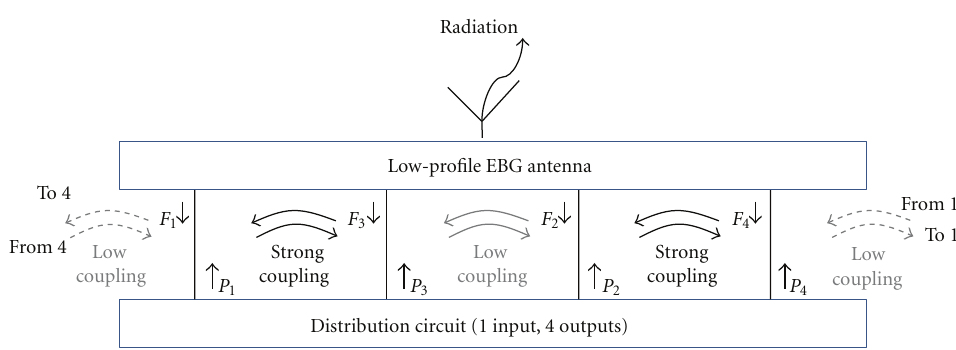
Figure 4: Illustration of the reflected field ( F i ) at each feed point i of the antenna when it is connected to the distribution